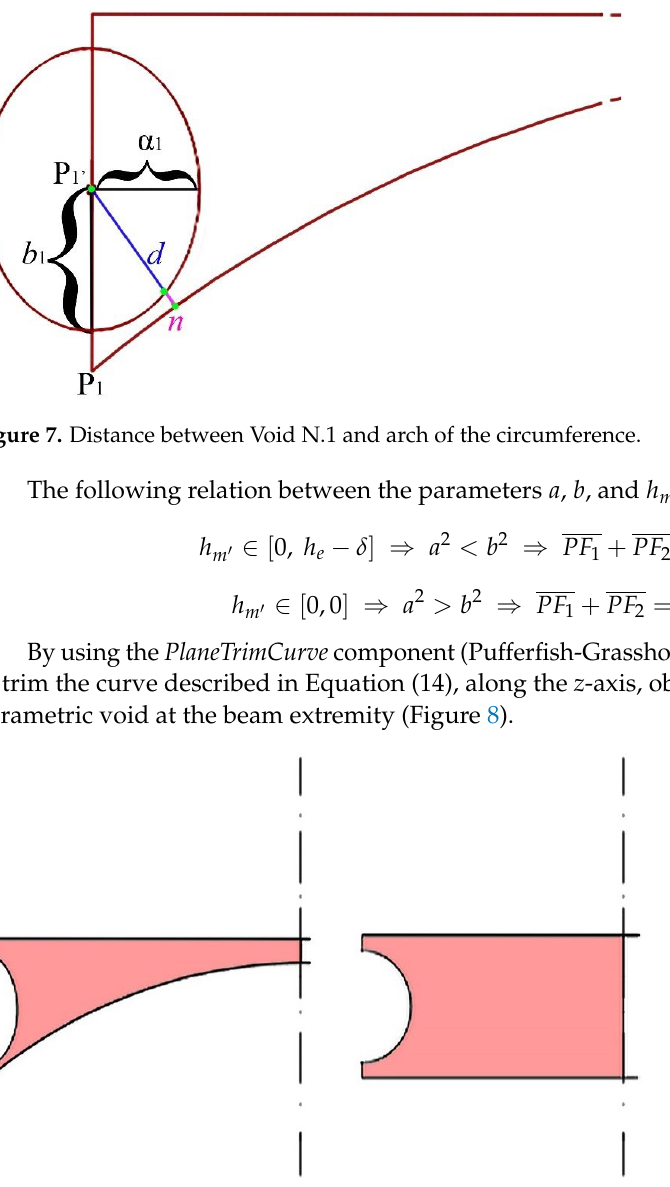
Figure 9. Division of the beam length. The configuration of voids depends on the parameter ℎ 𝑚𝑚 ′ (Equation (3)); as the value of ℎ 𝑚𝑚 ′ decreases, the size of the first half-void increases. To prevent overlaps be- tween the perimeters of the voids, it is necessary to shift the center of the second void: x 2′ = L 𝑐𝑐 𝑑𝑑 + ℎ m′ , max − ℎ 𝑚𝑚 2